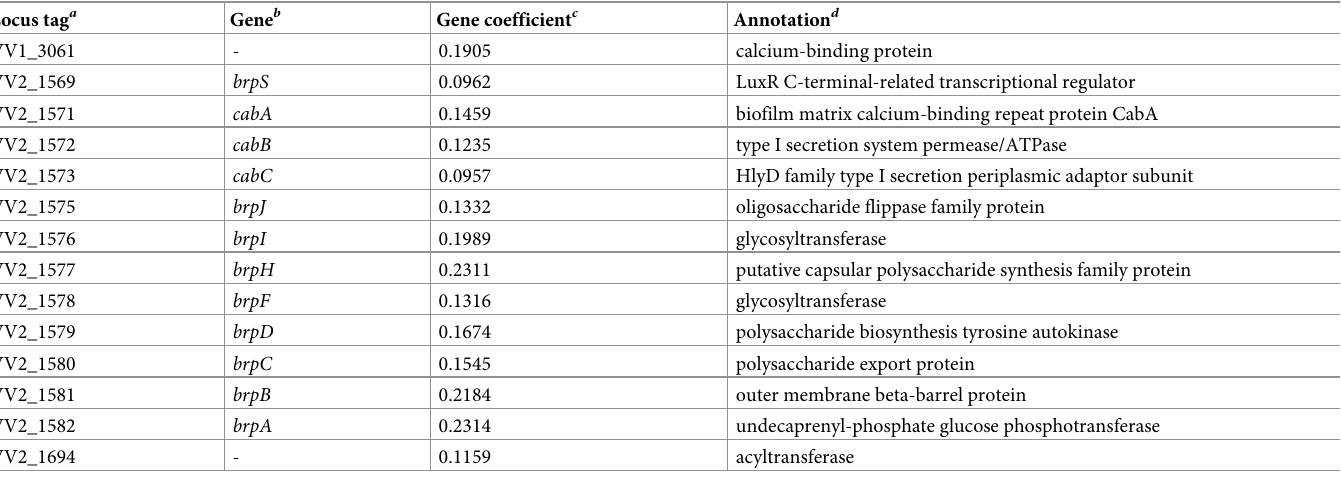
Table 1. The element genes included in the BrpT-iModulon. Locus tag a